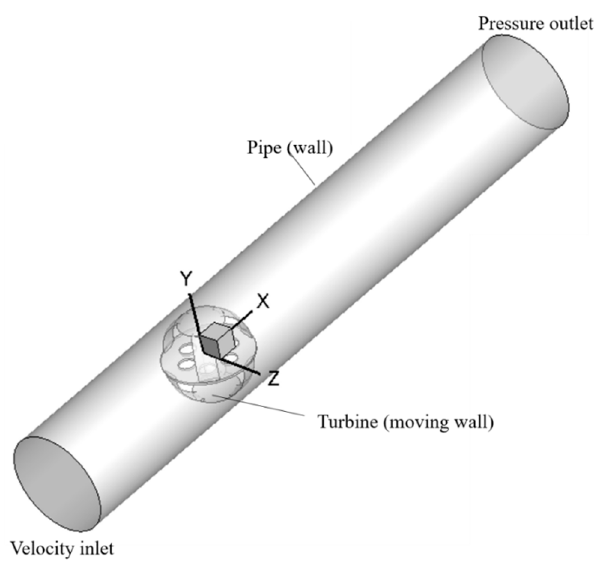
Figure 2. Turbine design: ( a ) side view and ( b ) top view.